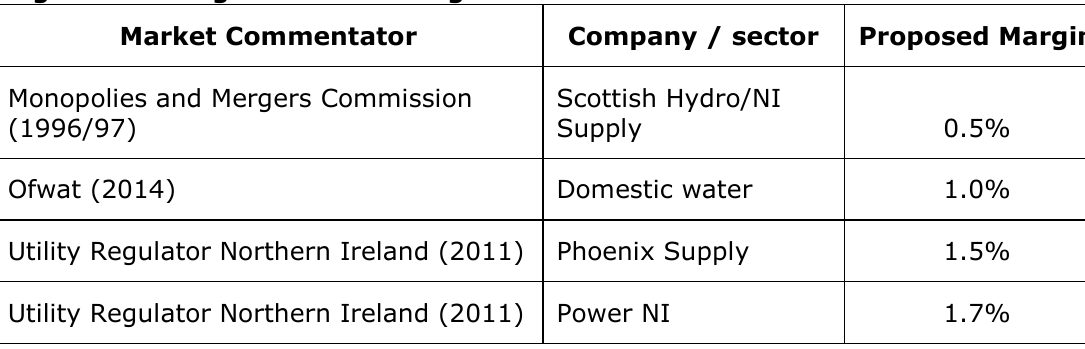
Figure 51: Margin benchmarking Market Commentator Company / sector Proposed